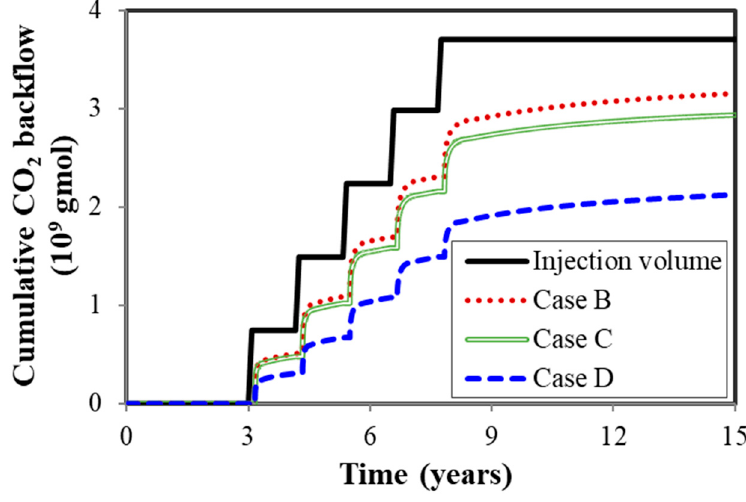
Figure 13. Comparisons of CO 2 storage capacity in different scenarios.